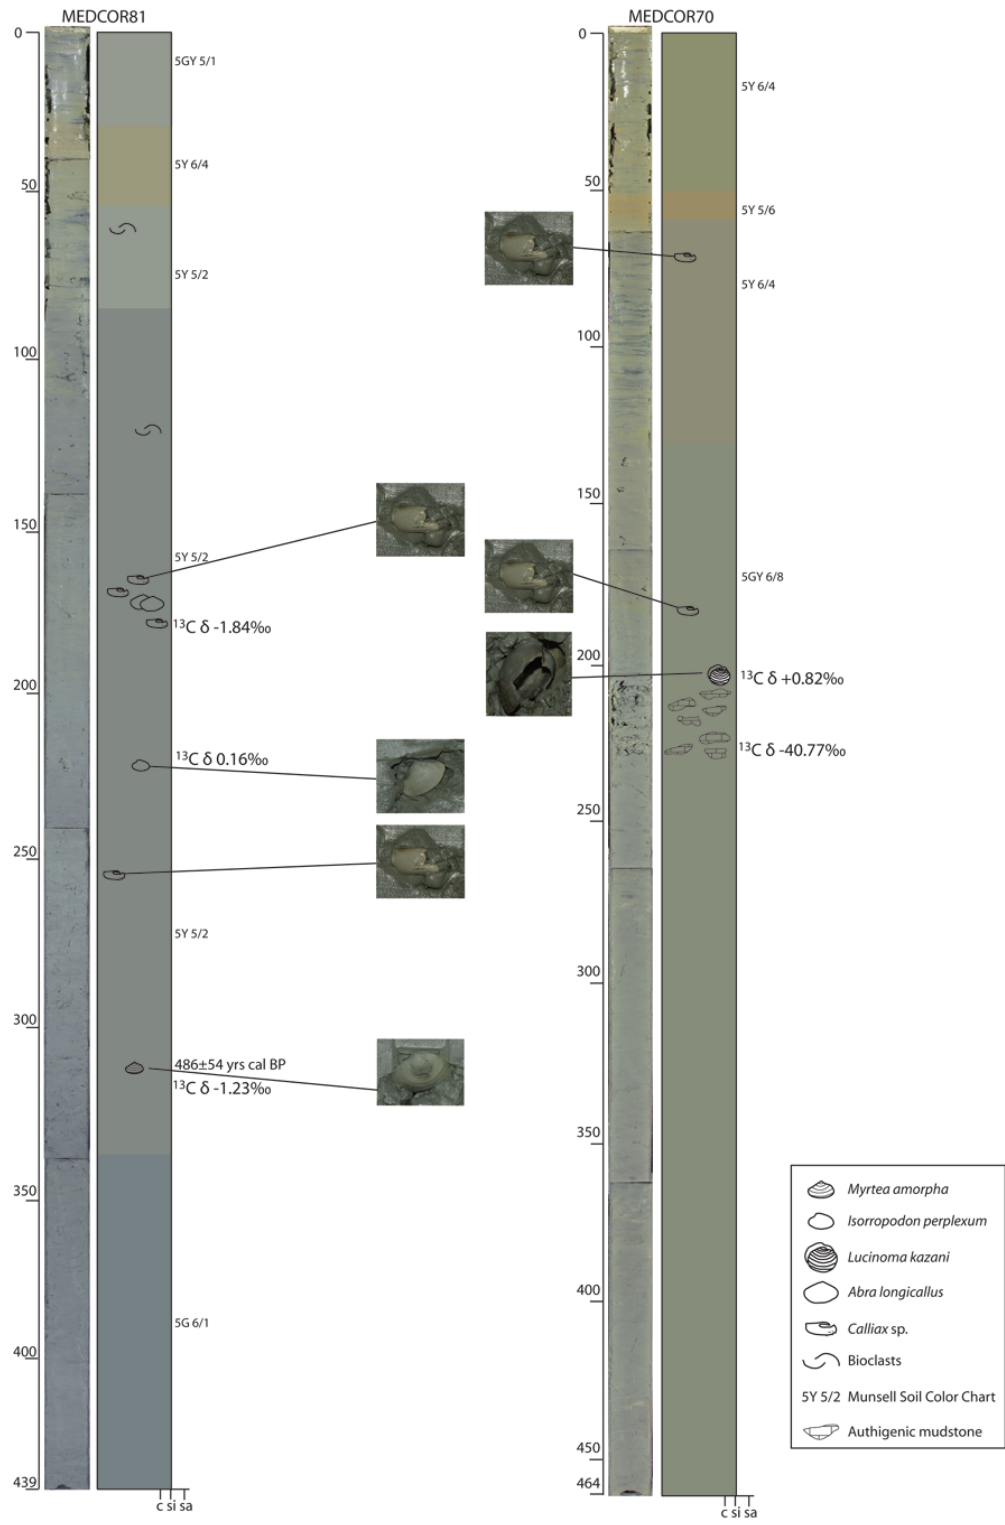
Fig. 11. Sedimentary cores MEDCOR81 (pockmark #1), and MEDCOR70 (pockmark #6): photographic (left) and (right) lithostratigraphic logs reporting main chronological, petrographic, isotopic and faunal